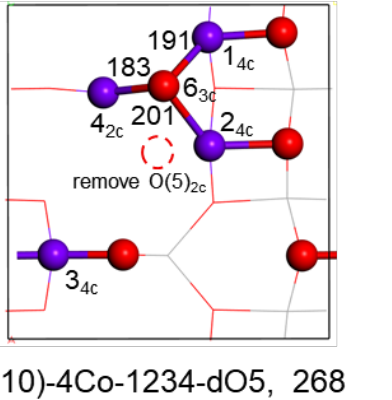
Figure 5. The structures for (110)-4Co-12345 and (110)-4Ni-12345 with one O defect. The dotted circle represents the removed O atom.